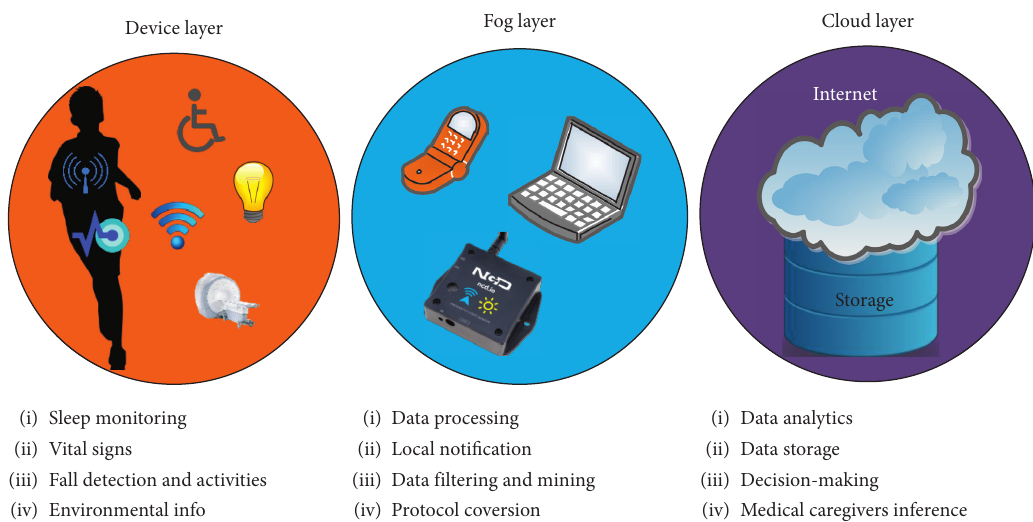
Figure 3: Conventional IoT healthcare